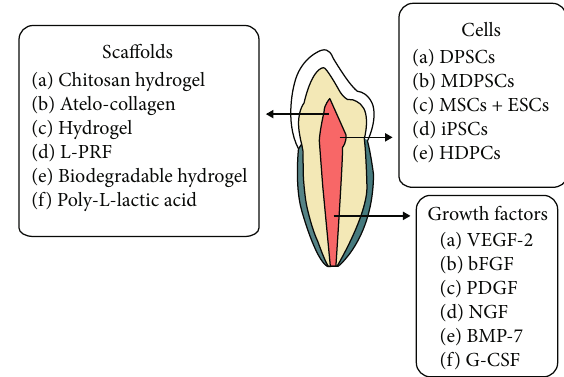
Figure 3: Diagram showing cells, growth factors, and sca ff olds examined in the fi eld of pulp regeneration.